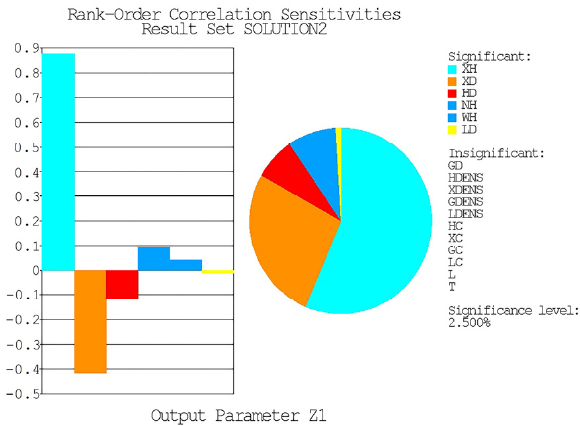
Figure 24. Z 1 sensitivity analysis.